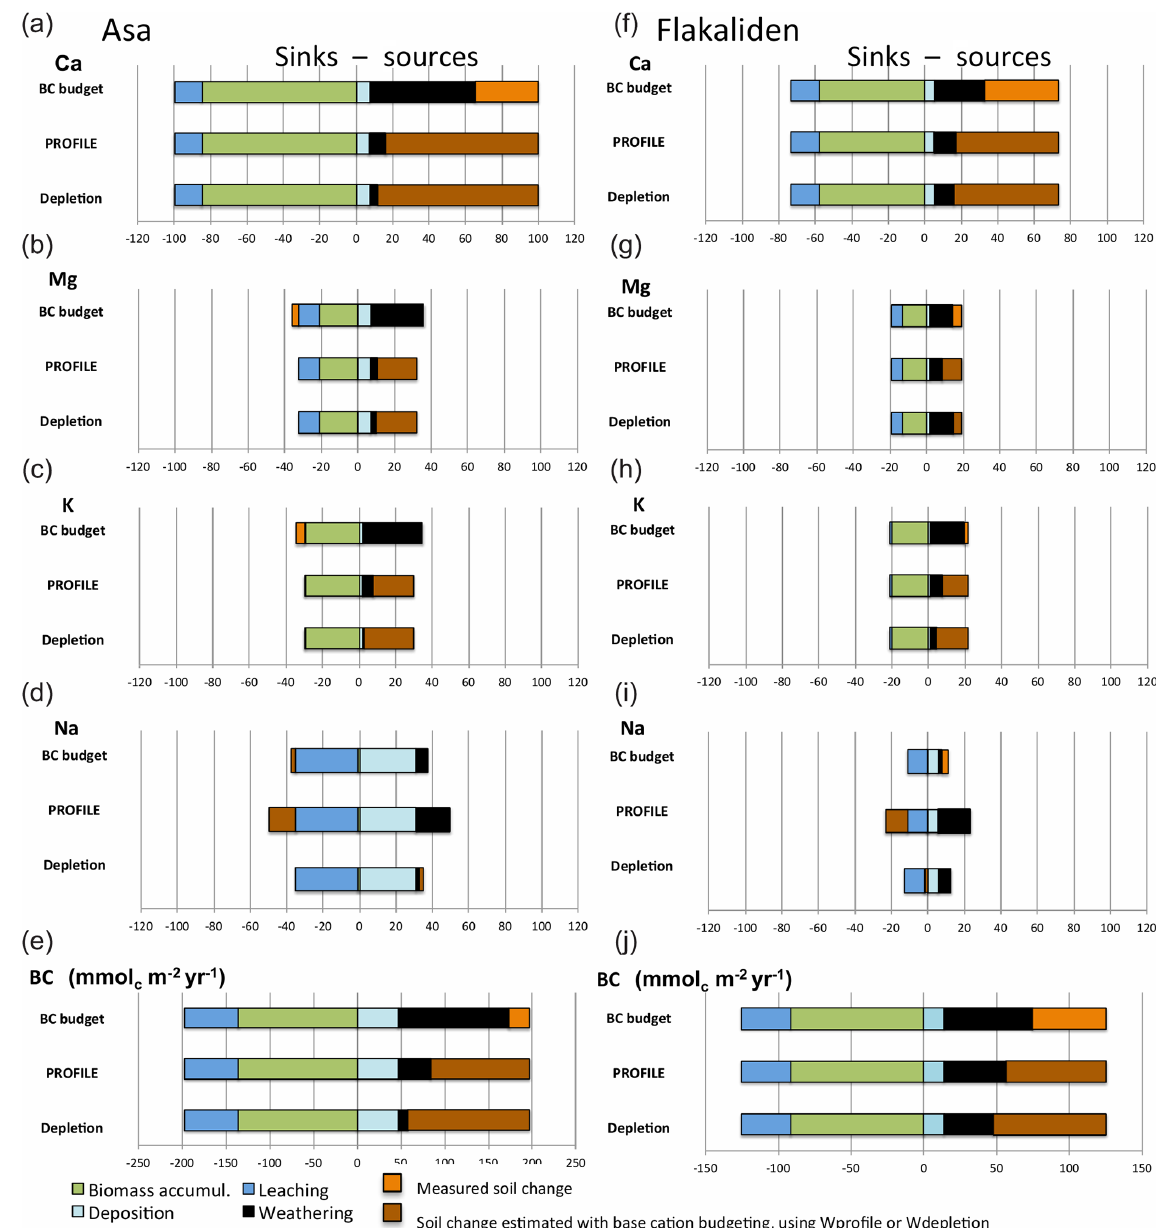
Figure 6. Sinks (left) and sources (right) of base cations (BC) in ecosystem net fluxes at Asa and Flakaliden. The soil is a net source of soil BC if soil base cation stocks decrease and a net sink if they increase. “BC budget” denotes current base cation weathering rate ( W budget ) estimated with the BC budget method, including measured changes in soil exchangeable BC stocks; “PROFILE” denotes soil exchangeable pools estimated from BC budget using PROFILE estimates of BC weathering rate; “Depletion” denotes soil exchangeable pools estimated from BC budget using estimates of historical weathering rate by the depletion method. “Measured soil change” and “Base cation budget estimated soil change” indicate that Eq. (4) was used to estimate weathering rate or the soil change,